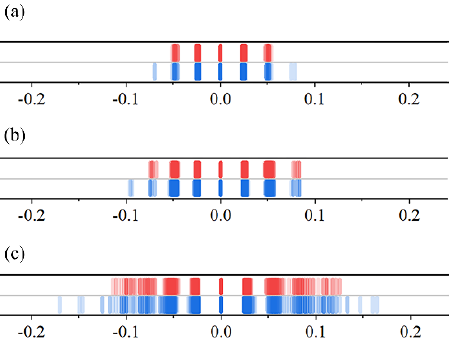
Figure 10. Schematic diagram comparing the numerical fluctuation frequency in the DSI under 𝜔 ≥ 1 : ( a ) 𝜔 = 1 ; ( b ) 𝜔 = 2 ; ( c ) 𝜔 = 4 (red represents the STAA and blue represents the TDAA [11]).